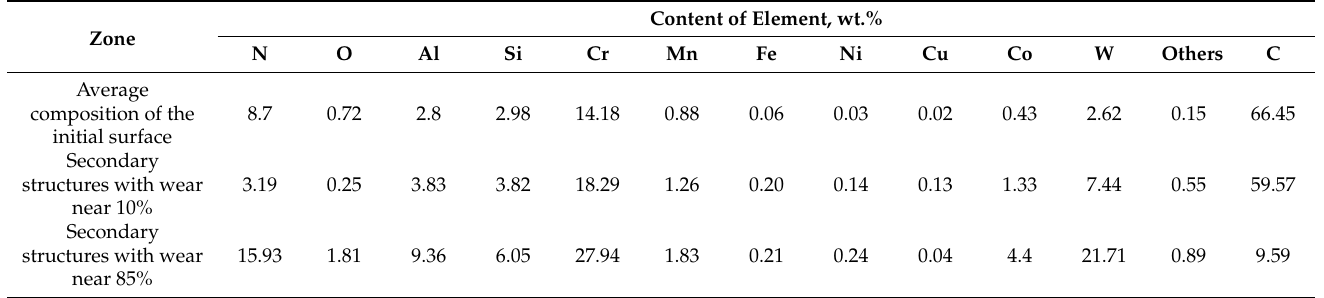
Table 5. Comparison of the compositions of secondary structures with the initial surface. Content of Element,